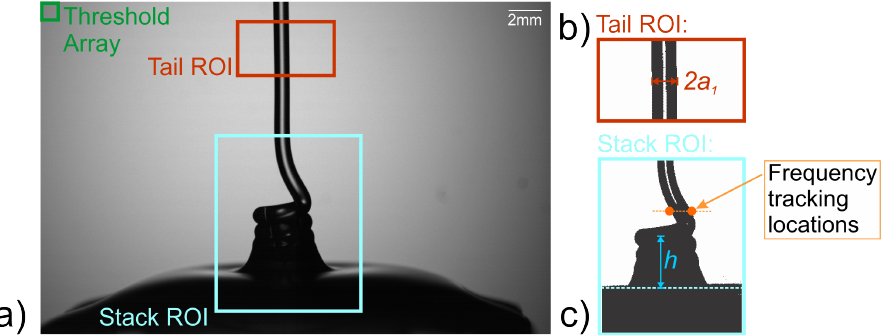
Figure 3. ( a ) Annotated locations of the threshold array, tail ROI, and stack ROI used in coil measurements. The ( b ) tail and ( c ) stack ROIs are thresholded into black and white before the annotated measurements are